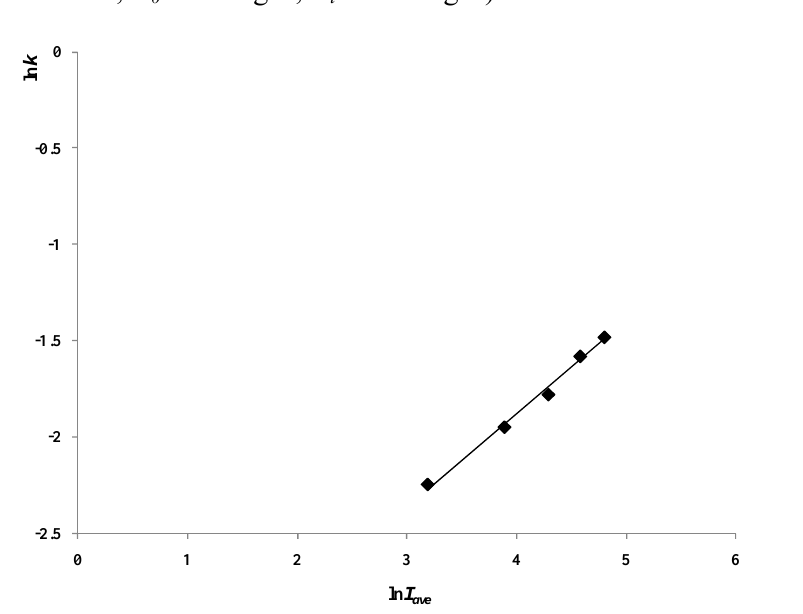
, with a slope of 0.4827 ave